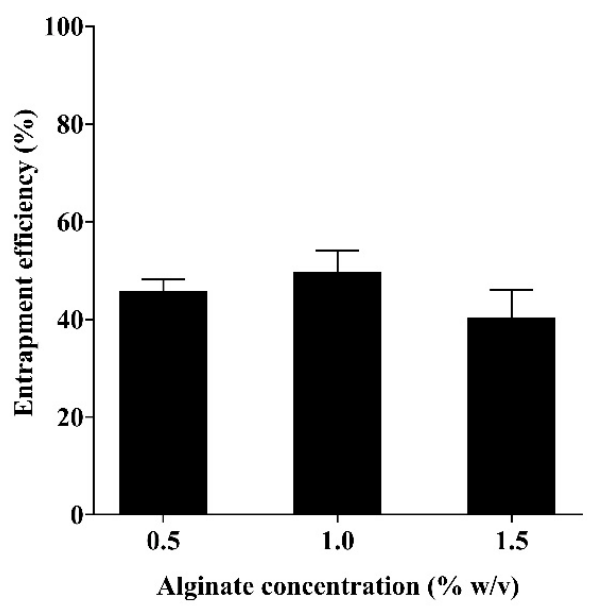
Figure 2. Encapsulation efficiency of bovine serum albumin (BSA)-loaded microparticles (MPs) at different concentrations of alginate.